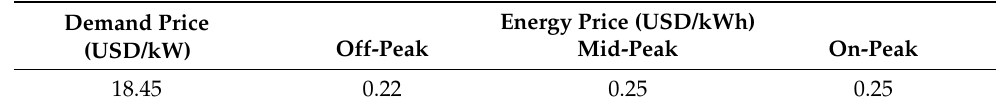
Table 1. Time-of-use tariff of Pacific Gas and Electric Company.